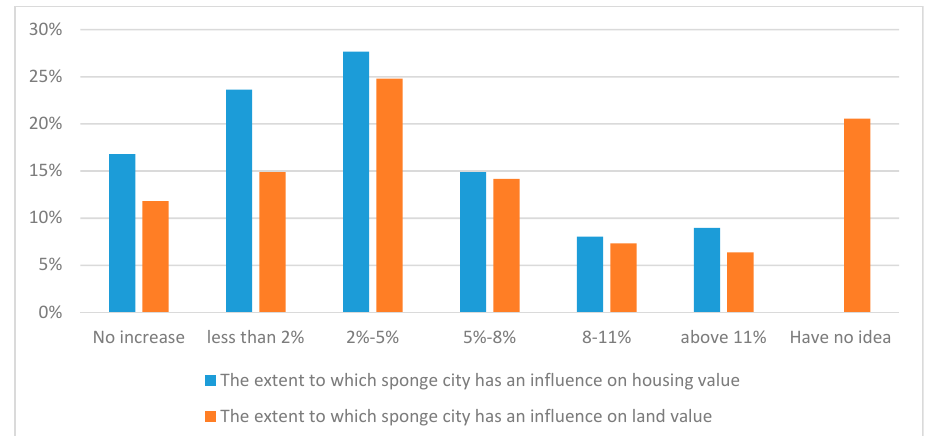
Figure 7. The extent to which sponge city influences housing and land values.